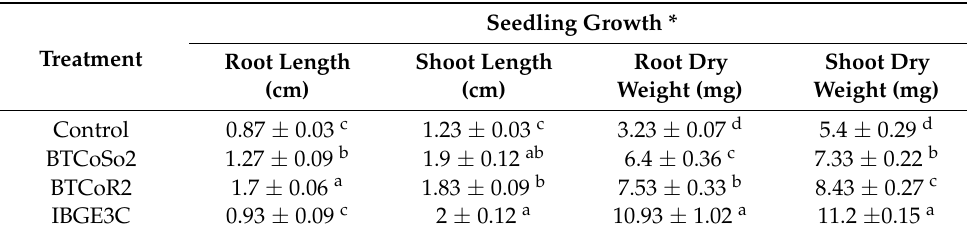
Table 3. Effects of bacterial isolates on seedling growth of BINAdhan-10 at 1% salinity. Values are mean and provided with standard error (significance level α = 0.05).